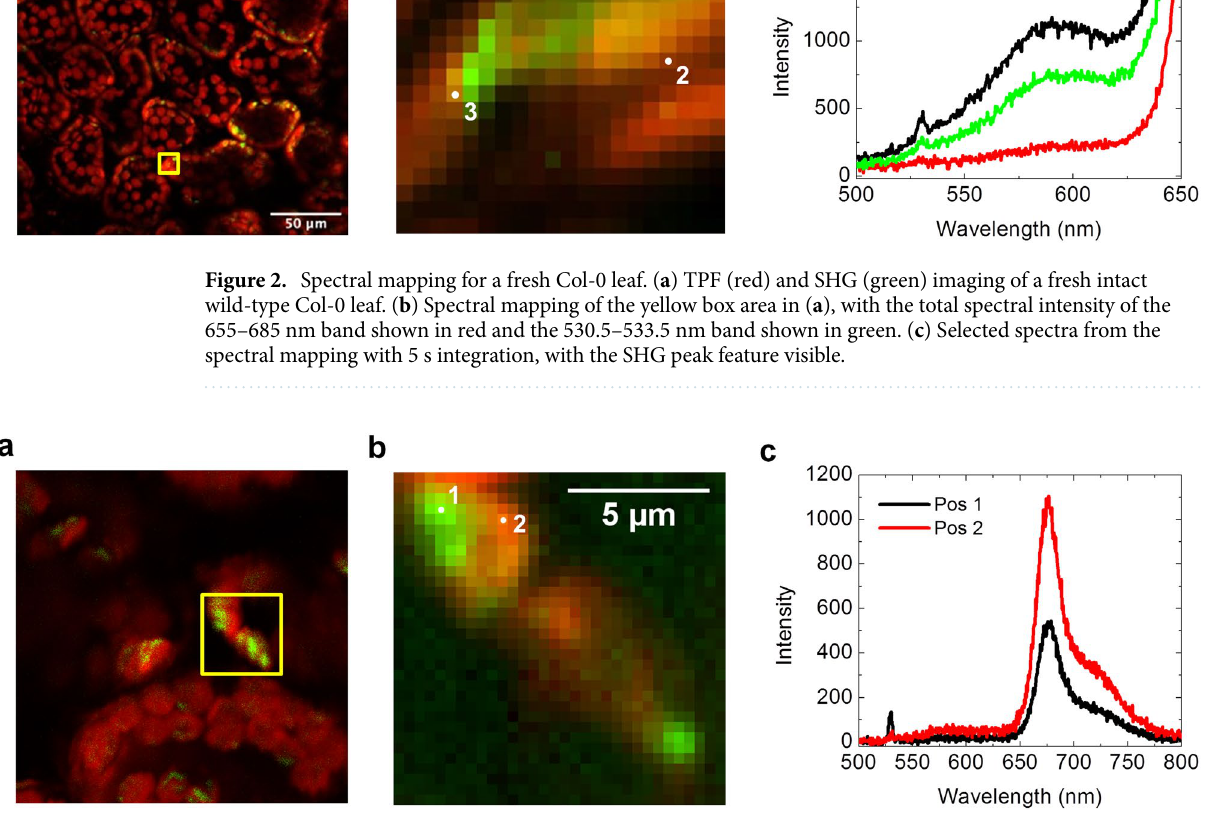
Figure 3. Spectral mapping for a fresh intact sex1 mutant leaf. a TPF (red) and SHG (green) imaging of a fresh intact sex1 mutant leaf. b Spectrum mapping of the yellow boxed area in ( a ), with the total spectral intensity of the 655-685 nm band shown in red and the 530.5–533.5 nm band shown in green. ( c ) Spectrum of selected points shown in ( b ) with 0.3 s integration. The Spectrum from point 1 show a SHG peak feature with a lower chlorophyll